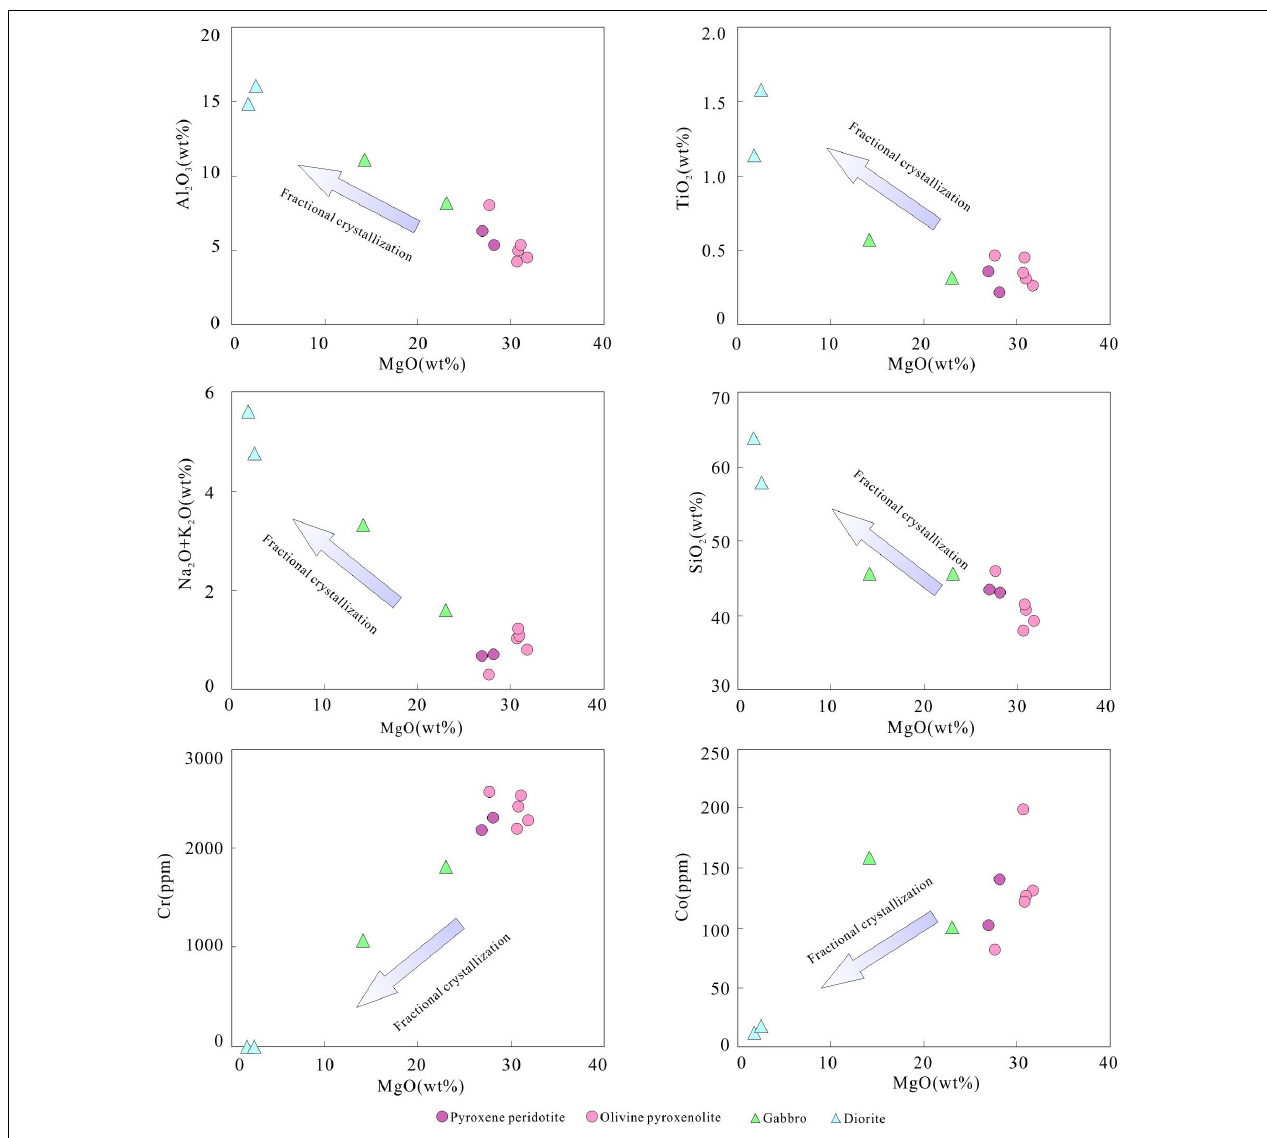
FIGURE 8 | Diagrams of MgO versus major oxides and compatible elements for the Lubei